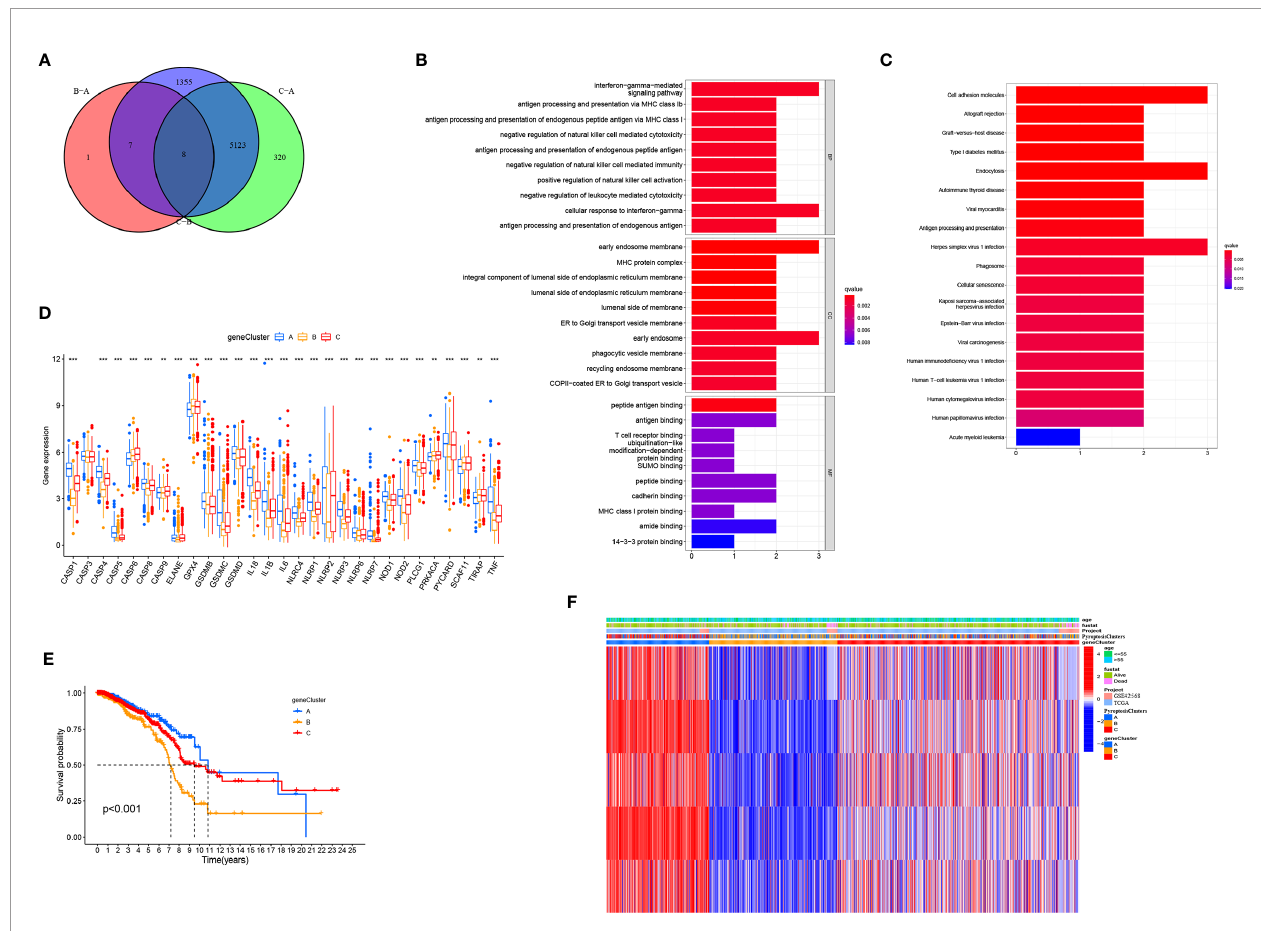
FIGURE 4 | Generation of pyroptosis-related genes signatures. (A) Venn diagram showing overlapping genes of three PyroptosisCluster subtypes. (B, C) Results of GO and KEGG enrichment. (D) Gene expression levels of pyroptosis-related genes in three geneCluster. (E) Kaplan – Meier curves showing the overall survival of geneCluster. (F) Heat map of the clinical relevance of PyroptosisCluster and geneCluster. * P < 0.05, ** P < 0.01, *** P <